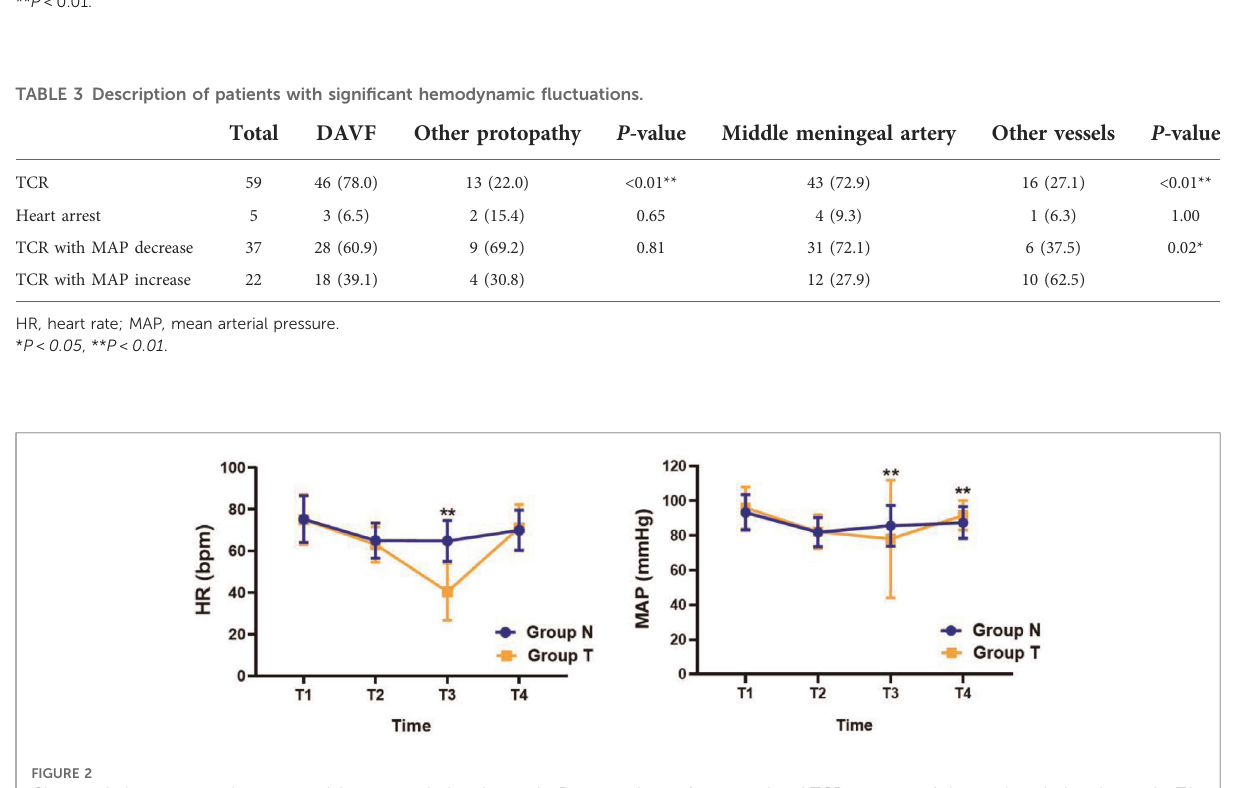
FIGURE 2 Changes in heart rate and mean arterial pressure during the study. Data are shown for control and TCR groups at 4 time points during the study: T1, 5 min before anesthetic induction; T2, 1 min before DMSO/Onyx injection; T3, at the moment of DMSO/Onyx injection; T4, at the end of the operation. * P<0.05 , ** P<0.01 , TCR group vs. the control group at certain time points. Abbreviations: HR, heart rate; MAP, mean arterial